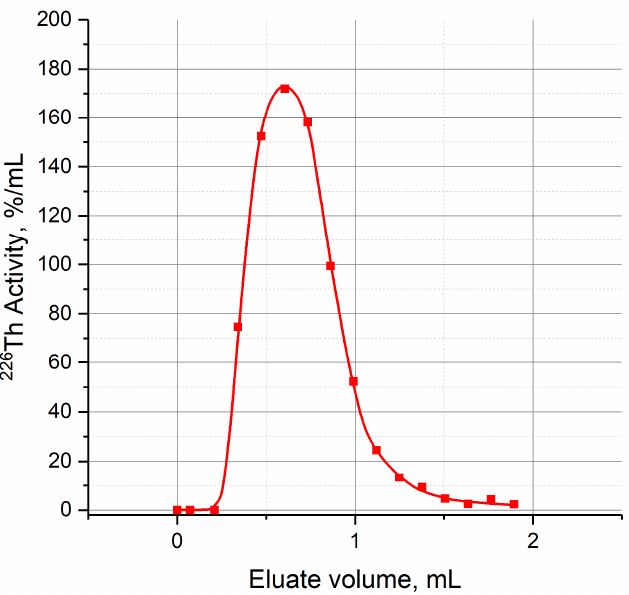
Figure A1. Typical curve of 226 Th elution from the first column with TEVA resin (1 mL).